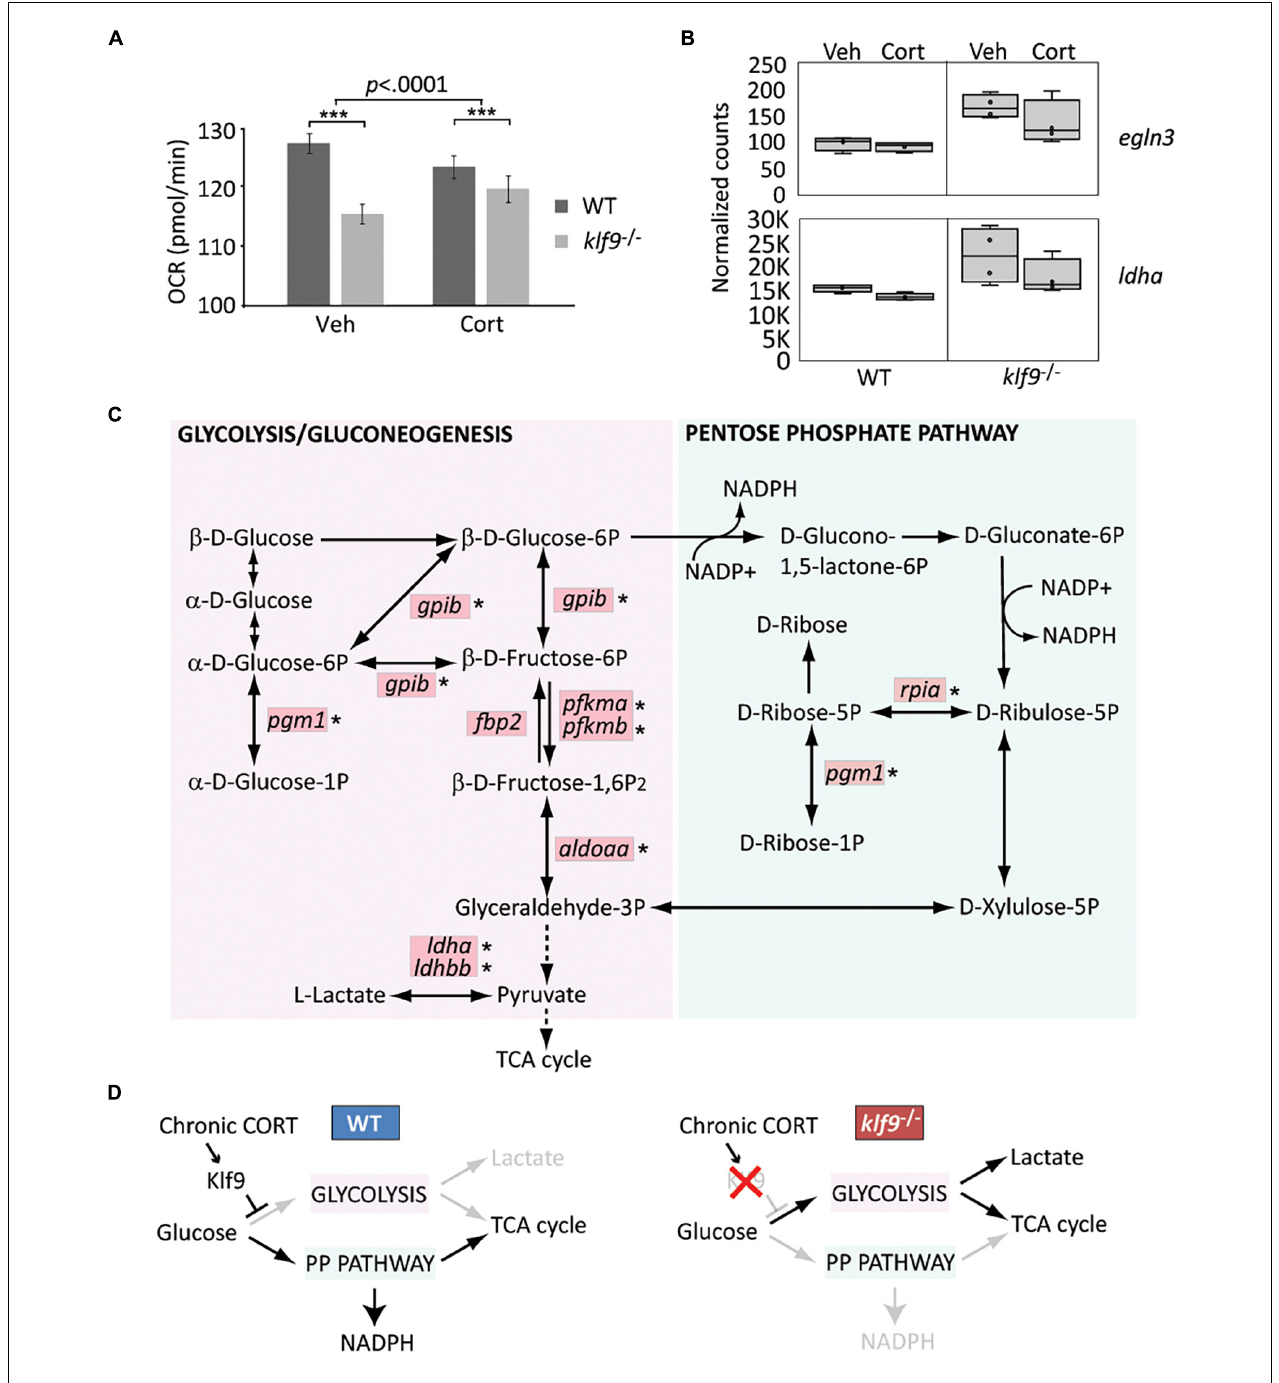
FIGURE 4 | Klf9 regulates metabolism. (A) Oxygen consumption rate (OCR) at 1 dpf, as measured by Seahorse XF96 extracellular flux analyzer. The averages of three experimental replicates are shown, each with 20 embryos per condition measured individually and simultaneously over the course of at least 85 min (thus n = 60 total for each condition). The bars represent the average Y-intercept of linear fits of the averaged time-course data (see Supplementary Figure 12 ), ± standard error. Two-way ANOVA indicated significant effects of both genotype (WT vs. klf9 − / − , p < 0.0001) and treatment (VEH vs. CORT, p = 0.04), as well as a significant interaction ( p < 0.0001). ***Adjusted p < 0.0001 by Šídák’s multiple comparisons test. (B) Normalized counts of Hif1a target egln3 and glycolytic gene ldha (from Gans et al., 2020). (C) Krüppel-like factor 9 (Klf9) downregulates multiple genes in the glycolysis/gluconeogenesis pathway. Red boxes indicate genes significantly over expressed (FDR < 0.05) in RNA-seq of klf9 − / − larvae compared to wild type (Gans et al., 2020). Asterisks denote genes in which putative Klf9 binding sites were identified using HOMER. (D) Model for Klf9-mediated regulation of metabolic flux. In response to stress, Klf9 is predicted to inhibit glycolysis, shunting flux through the Pentose Phosphate Pathway